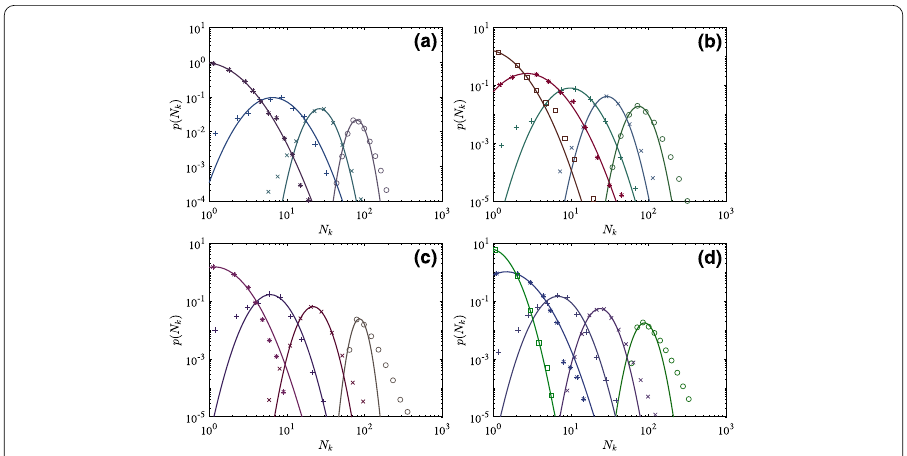
Figure 7 Probability distribution of the number of alters in different layers for the SVCN. The solid curves represent the best log-normal fits to the empirical distribution. ( a ) Egos with four layers obtained from the k -means algorithm. ( b ) Egos with five layers obtained from the k -means algorithm. ( c ) Egos with four layers obtained from the H / T break algorithm. ( d ) Egos with five layers obtained from the H / T break